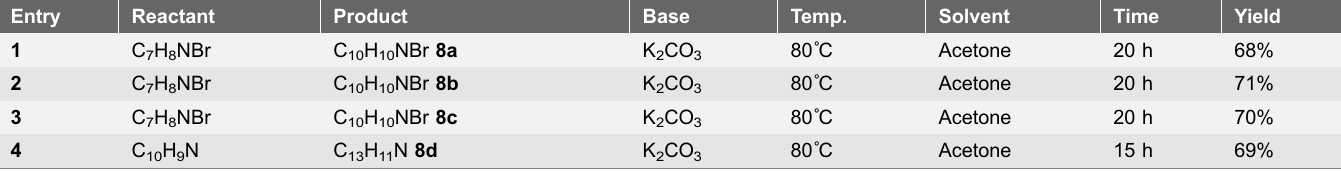
Table 4. Optimization of reaction conditions for compounds 8a–d